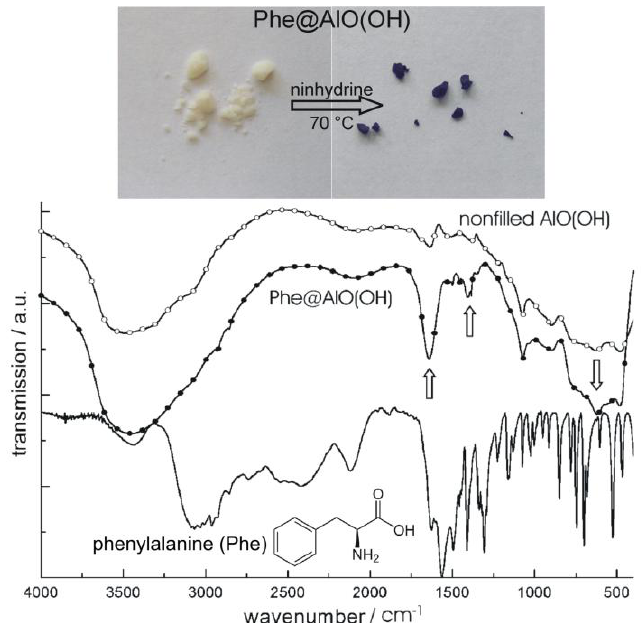
Figure 18. Photos of Phe@AlO(OH) before and after reaction with ninhydrine and FT-IR spectra of Phe@AlO(OH) (vibrations of Phe indicated by arrows; nonfilled AlO(OH) hollow spheres and pure phenylalanine as references; modified reproduction from